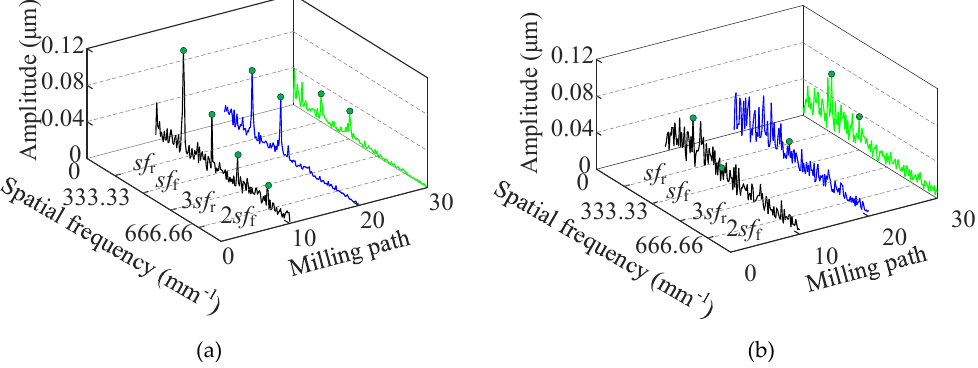
Figure 7. The fast Fourier transformation (FFT) spectra of the machined surfaces. ( a ) The BMG material; ( b ) the aluminum material.